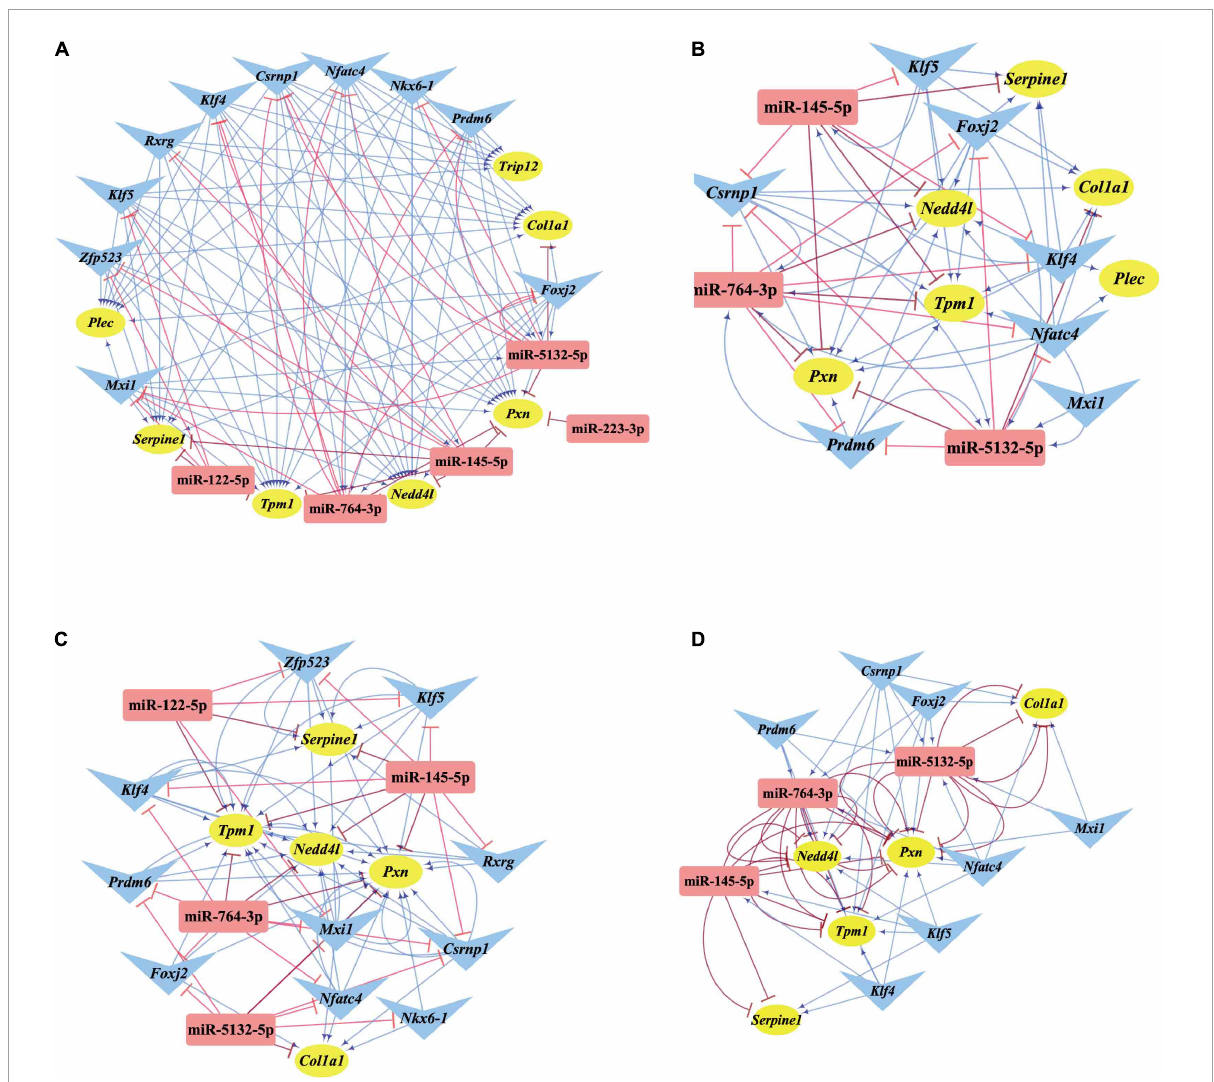
FIGURE7 Regulatory relationships of the M-T-G subgraph network, composite loops, and FFLs. (A) Establishment of the M-T-G subgraph network of the key nodes based on 7 DEGs, 10 DETFs, and 5 DEMs. (B) Summary of all the composite loops based on the M-T-G subgraph network. (C) Collection of the miRNA-mediated FFLs extracted from the M-T-G subgraph network. (D) Gathering of TF-mediated FFLs of key DETFs. The target genes, miRNAs, and TFs are represented with yellow circles, red rectangles, and blue triangles, respectively. The edges radiated from miRNAs are marked in red and T-shaped blunt arrow ends, while the edges projecting from TFs are marked in blue and sharp arrow